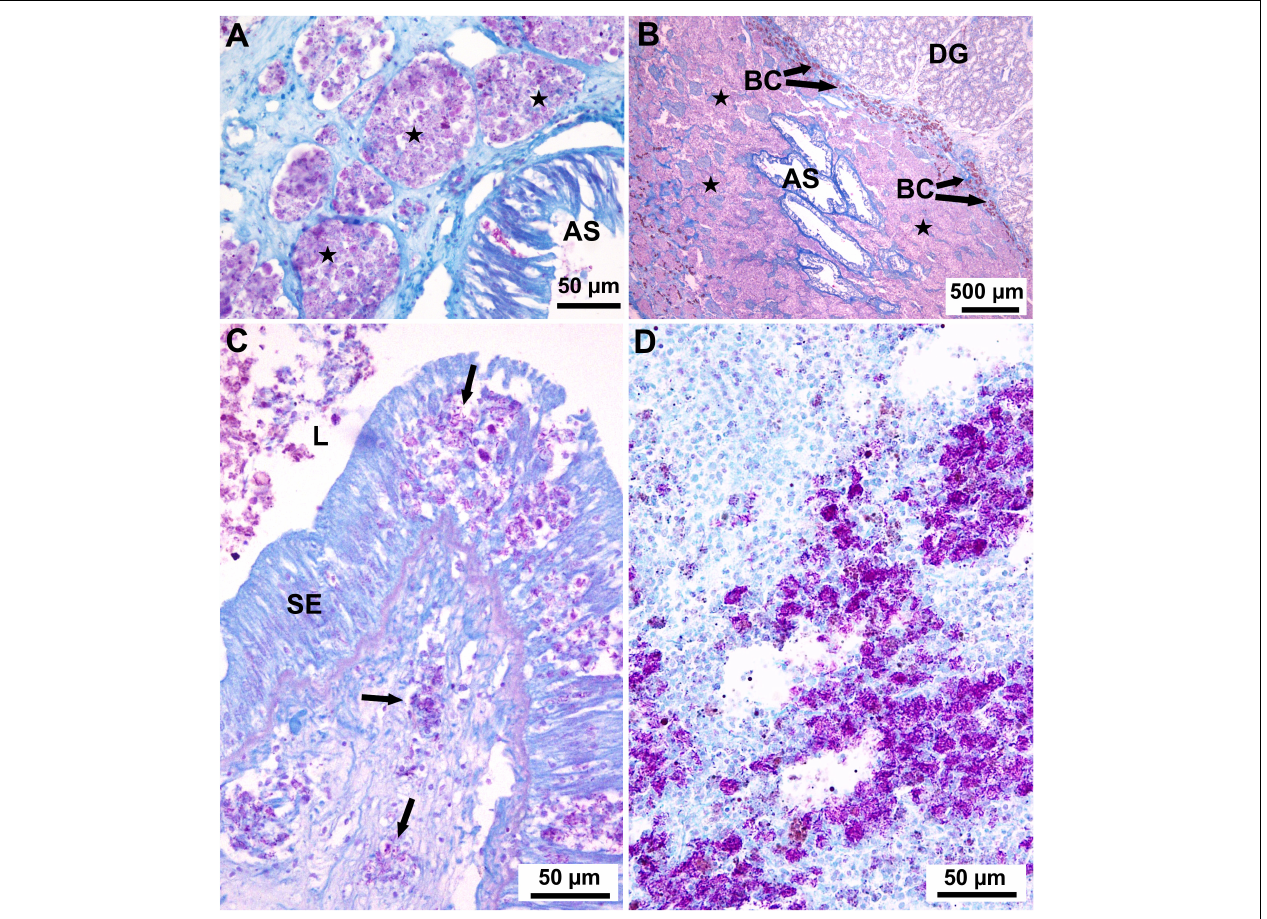
FIGURE 3 | Light micrographs of histological sections through the visceral mass of fan mussels Pinna nobilis stained with Ziehl-Neelsen to show infection with mycobacteria. (A) Aggregations of haemocytes filled with mycobacteria (purple deposits) forming nodules (stars) in the connective tissue surrounding the anterior stomach (AS; Cabrera, January 2012). (B) Low magnification showing massive aggregation (stars) of haemocytes filled with mycobacteria throughout the connective tissue surrounding the anterior stomach (AS); BC: brown cells; DG: digestive gland (Cabrera, November 2011). (C) Section through the stomach showing free haemocytes (not enclosed in nodules, arrows) filled with mycobacteria (purple deposits), both in the stomach epithelium (SE) and in the subjacent connective tissue; L, lumen of the stomach (Majorca, March 2017). (D) Section through the connective tissue showing masses of mycobacteria (purple deposits) spreading outside haemocytes (Minorca, June 2017).